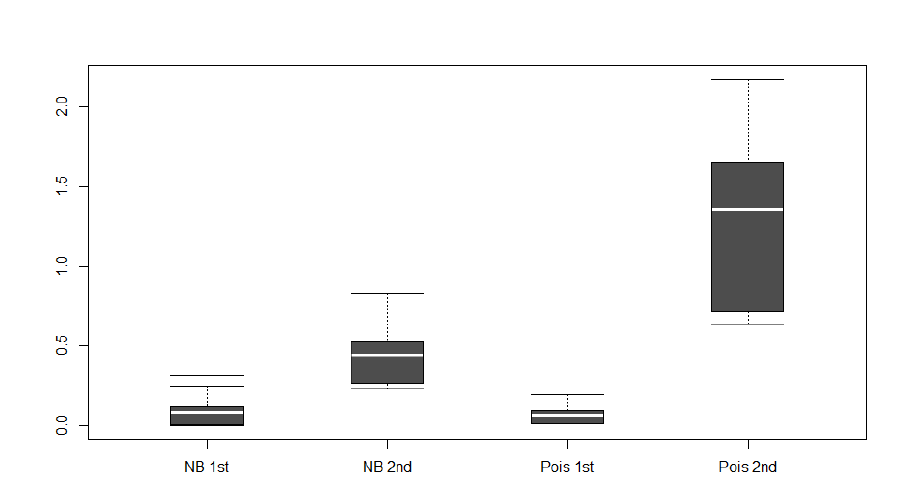
Figure 1. Boxplots of the fitted means for each of the two components for both